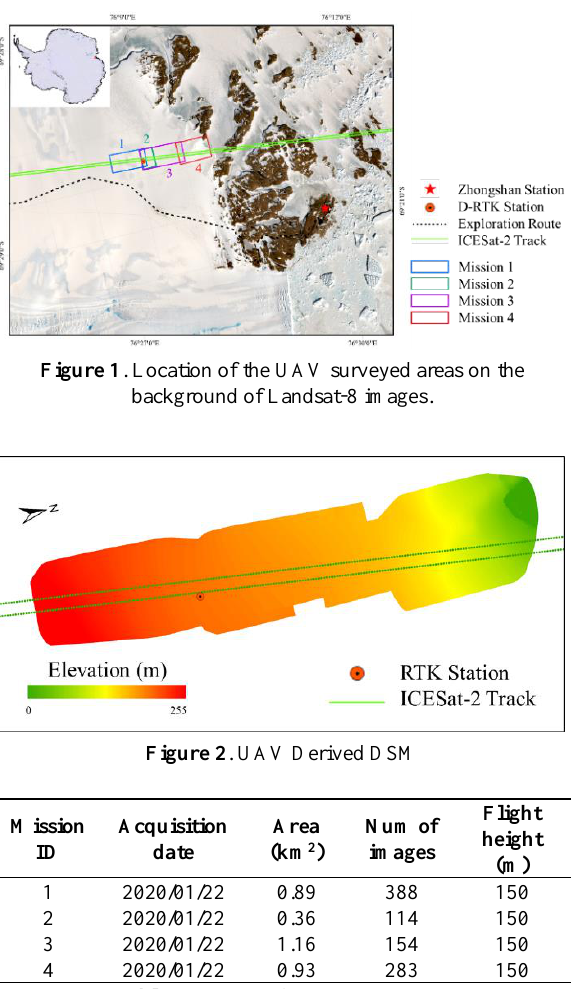
Table 1 . Details of the UAV surveys.